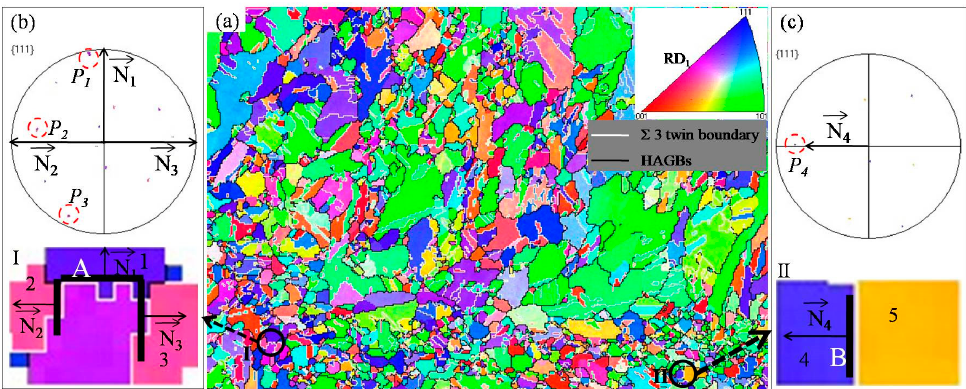
Figure 10. Identity of incoherent Σ 3 ic and coherent Σ 3 c during recrystallization nucleation: ( a ) IPF maps superimposed by both Σ 3 twin boundaries and HAGBs; ( b ) local area magnification of area I in ( a ) and corresponding {111} pole figure; and ( c ) local area magnification of area II in ( a ) and corresponding {111} pole figure. Five grains with different orientation is marked with numbers 1–3 in area I and numbers 4, 5 in area II.